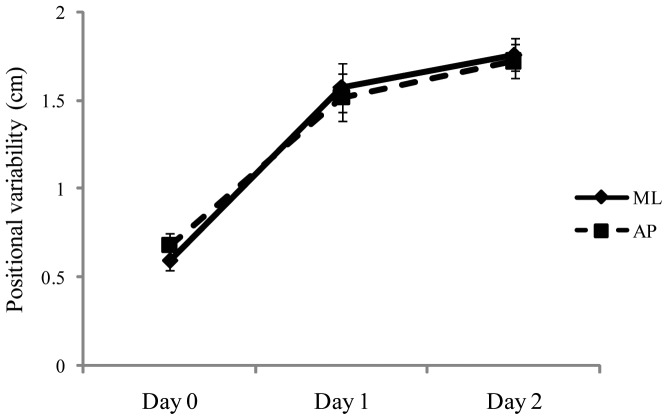
Experiment 2: Mean positional variability of the COP for the AP and ML axes, as a function of days.The figure illustrates the statistically significant interaction between axes and days. The error bars represent standard error of the mean.